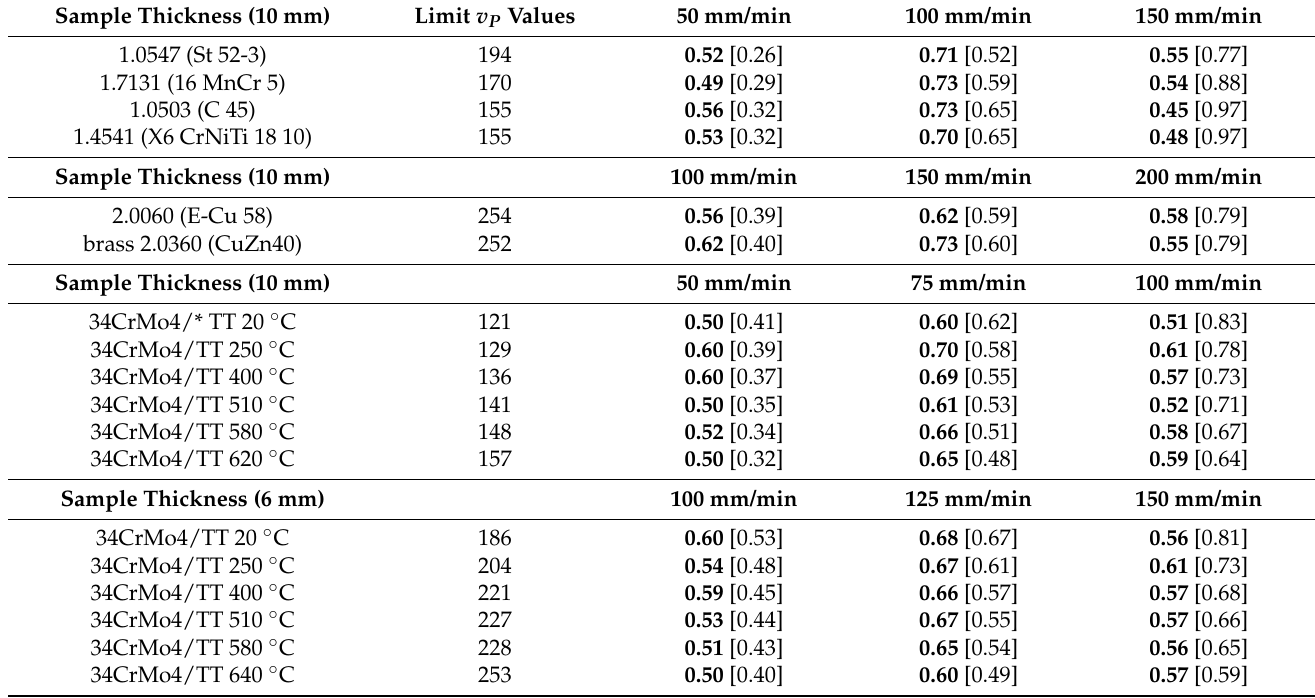
Table 4. The ratio of the x and z forces (cutting and deformation) measured by force sensor with different traverse speed sets (bold signed values), the respective limit traverse speeds are in a separate column and the relative traverse speeds are presented in brackets [